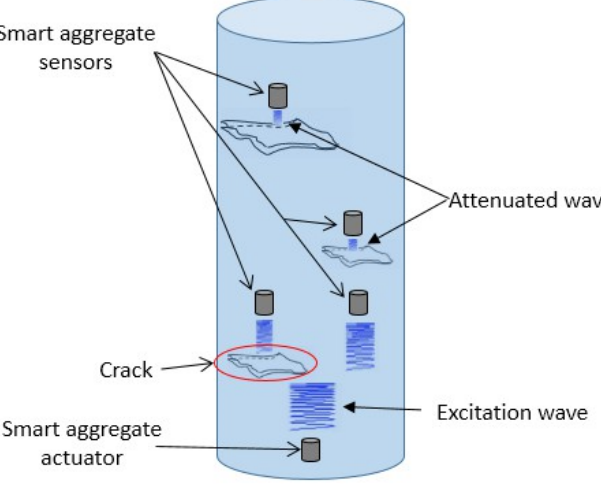
Figure 2. Schematic diagram of smart aggregate-based active sensing approach.